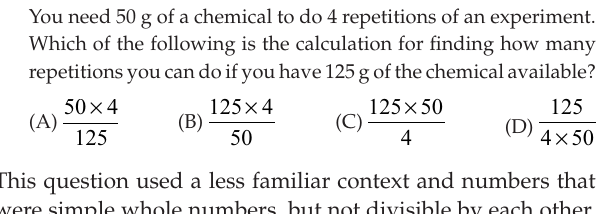
TABLE 2: Percentages of candidates ( N = 5 444) who selected the different alternative answers to questions. Correct answers in bold type. Alternative answer Missing value